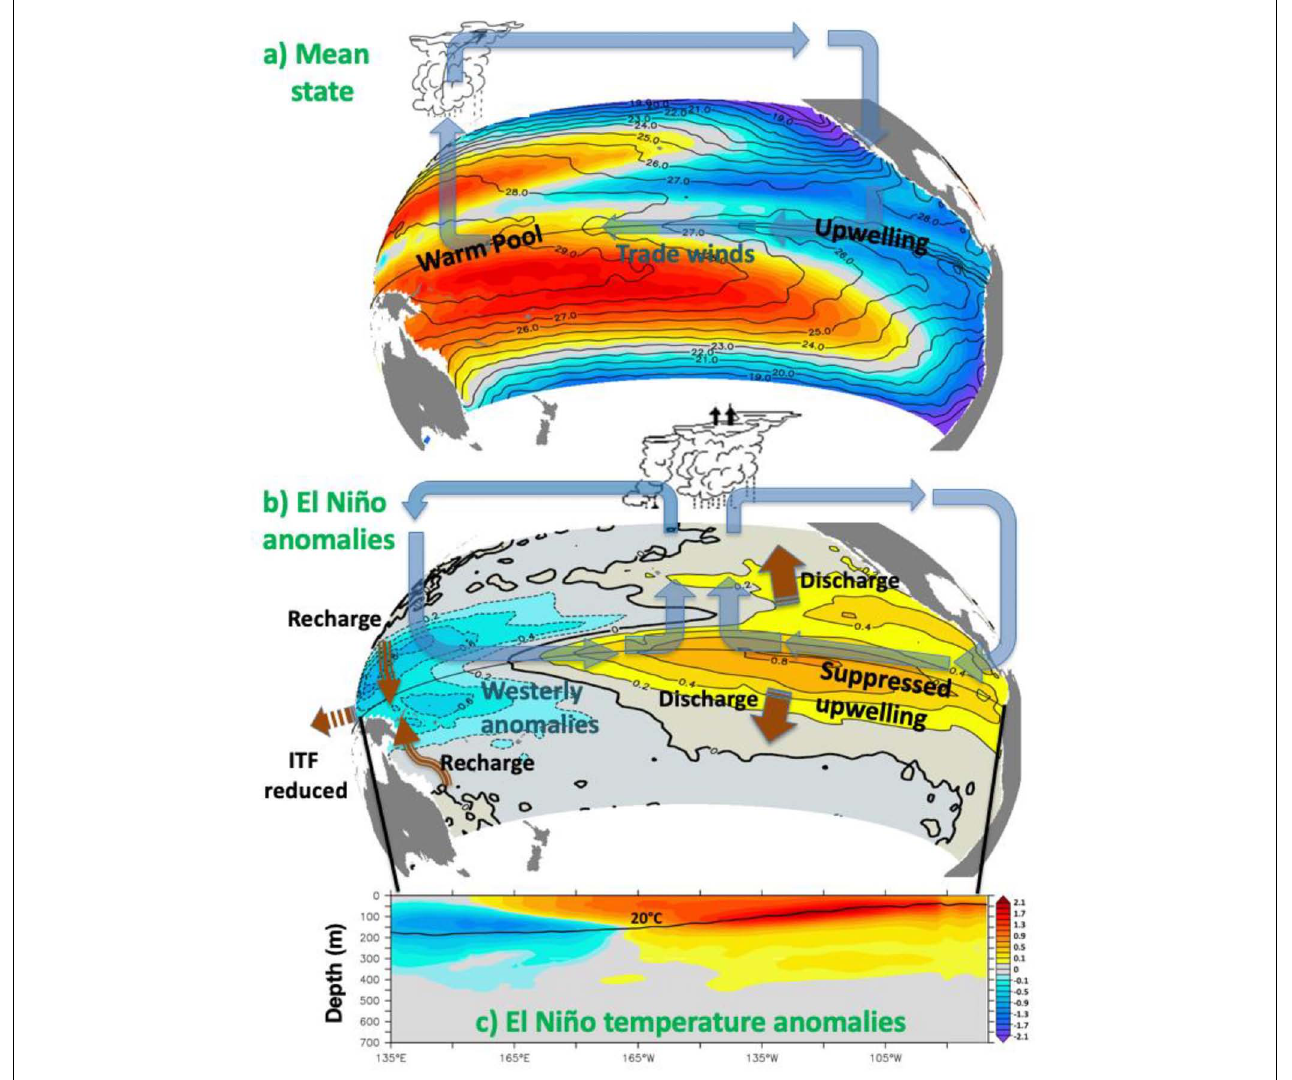
FIGURE 6 | Schematics of the oceanic and atmospheric processes in the mean state (a) and El Nino state (b,c) . (a) Mean 0–300 m heat content from Argo gridded product (colors), and mean SST (contours). In the mean state, easterly trade winds produce eastern upwelling, fostering higher sea surface temperatures and atmospheric convection in the west. That in turn strengthens the easterly surface winds in a positive feedback. Upper oceanic heat content is larger in the southwestern and northwestern parts of the basin. (b,c) 0–300 m temperature anomalies regressed onto Nino3.4 index during the 2004–2016 period, both for the upper 0–300 m layer (b) , and for the vertical equatorial section to 700 m depth (c) . The mean position of the 20 ◦ C isotherm is also shown. ITF = Indonesian